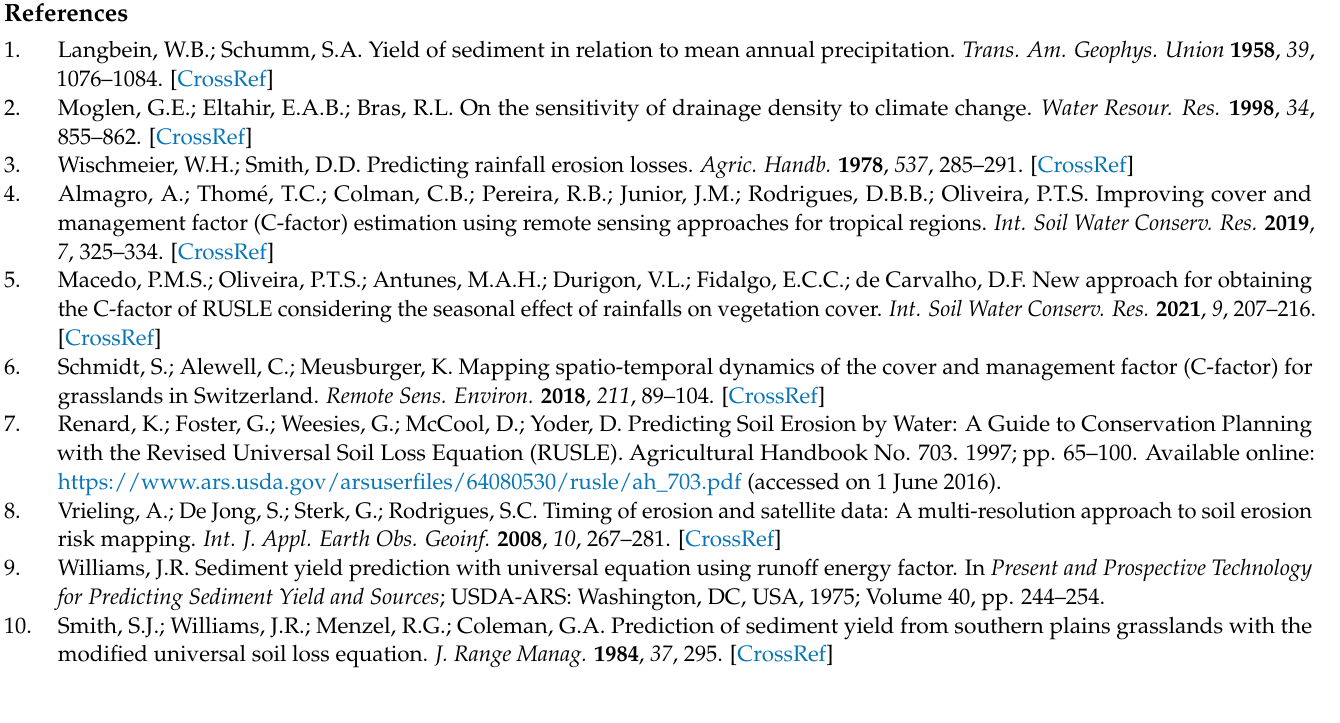
Table S3: Average MUSLE factors (including fixed C ) calculated for the